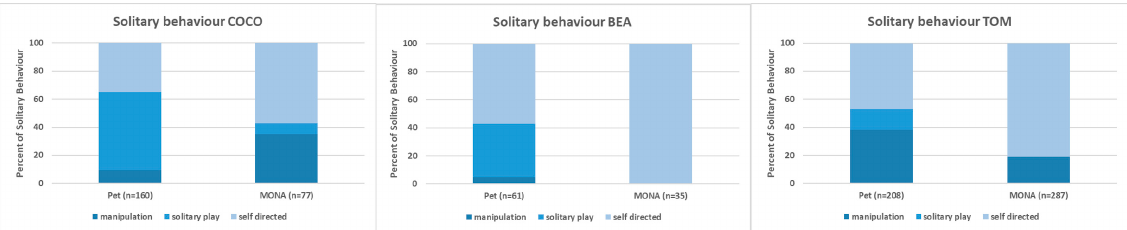
Figure 2. Comparison of the activity budgets while housed as pets (left) and after living at MONA for about 10 years (right) for ( a ) Coco, ( b ) Bea and ( c ) Tom. Figure 3. Comparison of the proportions spent on the different subcategories of feeding behaviour while housed as pets and at MONA for Coco ( left ), Bea ( middle ) and Tom ( right ). The comparison of the proportion of time spent on the subcategories of solitary behaviour (i.e., object manipulation, solitary play, and self-directed behaviour such as autogrooming and inspection of the own body; see Figure 4) revealed a decrease in manipu- lating objects in Bea (4.9% vs. 0%) and Tom (38.0% vs. 18.8%), but an increase in Coco (9.4% vs. 35.1%). Solitary play decreased or even disappeared in all three individuals (Bea: 37.7% vs. 0%, Coco: 55.6% vs. 7.8%, Tom: 14.9% vs. 0%), whereas the proportion of self-directed behaviour increased for all of them (Bea: 57.4% vs. 100%, Coco: 35.0% vs. 57.1%, Tom: 47.1% vs. 81.2%; Figure 4).